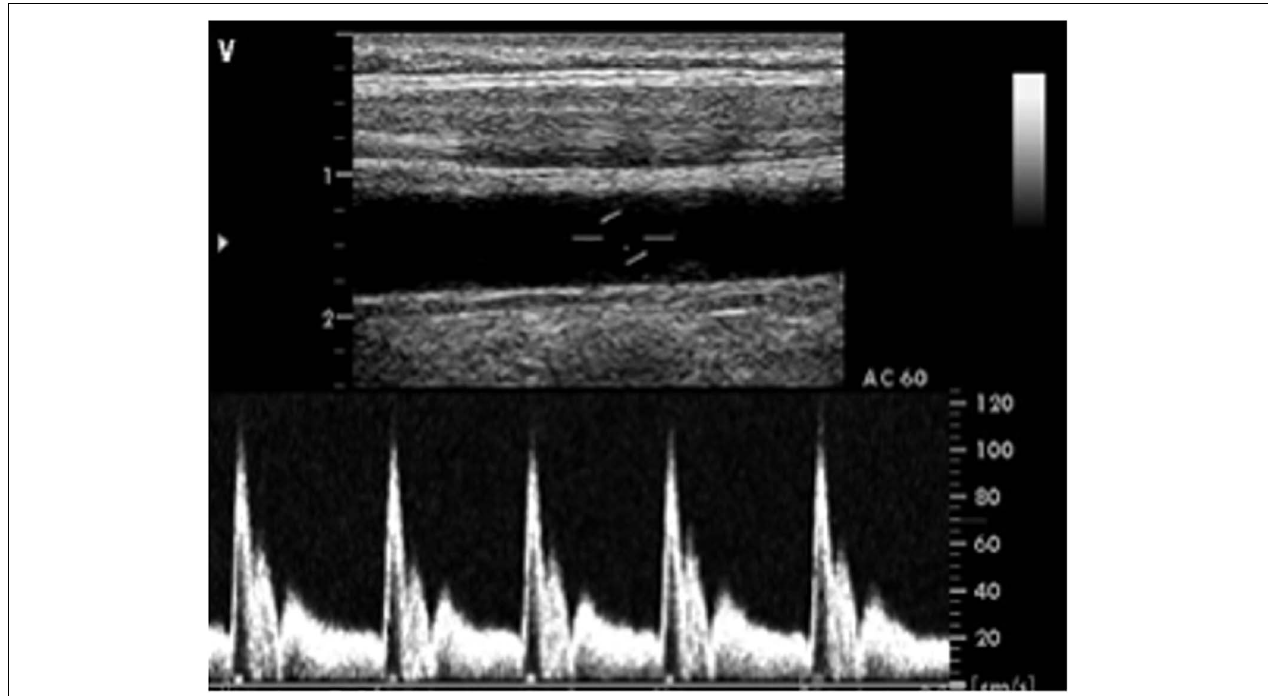
FIGURE 7 | Vascular duplex sonography scan of the left carotid artery showing the longitudinal image of the artery (top) and the corresponding Doppler pulse wave velocity trace (bottom)